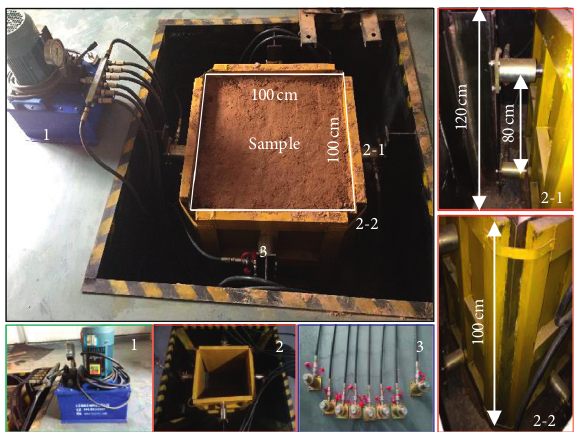
Figure 4: Gradation curve of the base soil.